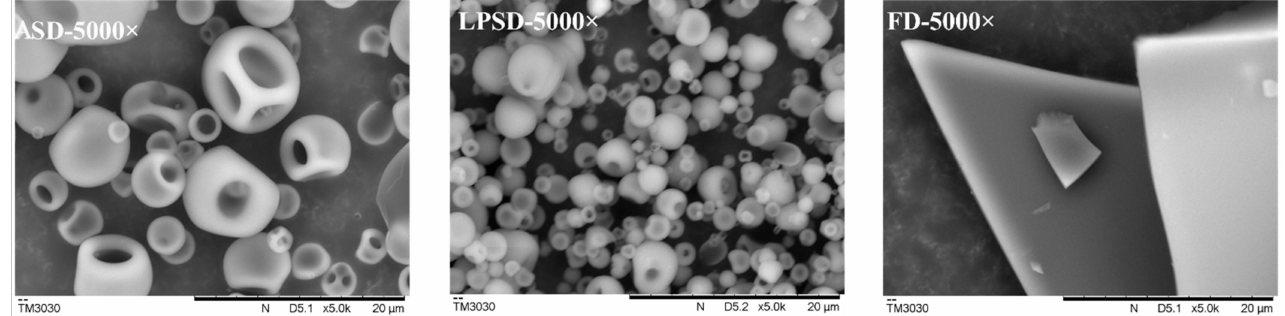
Figure 2. Surface microstructure of serum protein powder prepared by ASD, LPSD and FD.